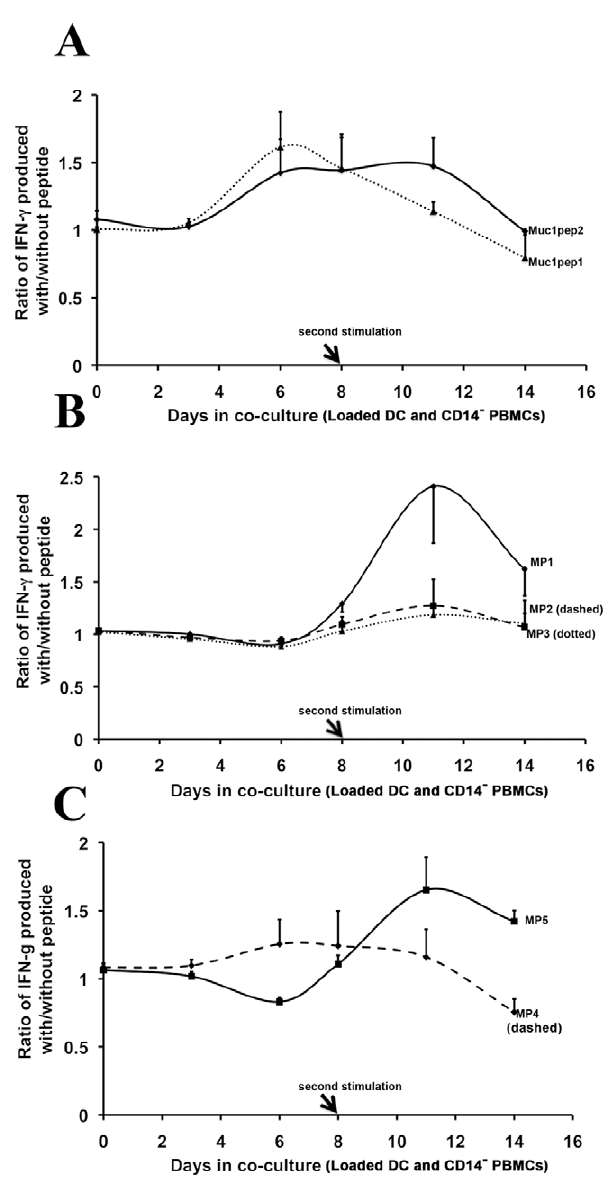
Figure 3. Immunostimulation of CD14- cells with peptide- loaded DCs. A. CD14 2 cells were co-cultured with DCs loaded with MUC1pep1 core peptide (dotted line) or MUC1pep2 core peptide (solid line). After 8 days (arrow), the cells were re-stimulated by addition of a fresh batch of autologous DCs. T-cell stimulation was monitored by quantifying the amount of IFN- c released into the medium. The IFN- c levels were normalized to the levels produced following incubation with DCs that had no peptides loaded. Error bars represent the normalized % error from two independent experiments. B. As in A except that DCs were loaded with MP1 (solid line), MP2 (dashed line) or MP3 (dotted line). C. As in A except that DCs were loaded with MP4 (dashed line) and MP5 (solid